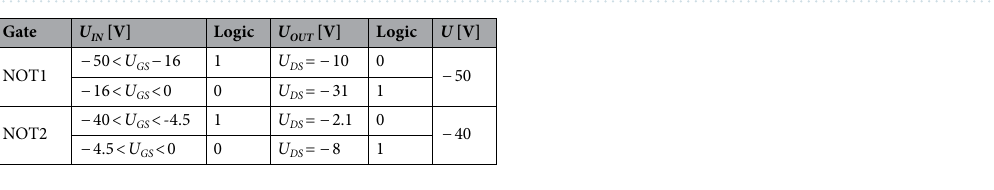
Table 2. Truth table for the inverters.